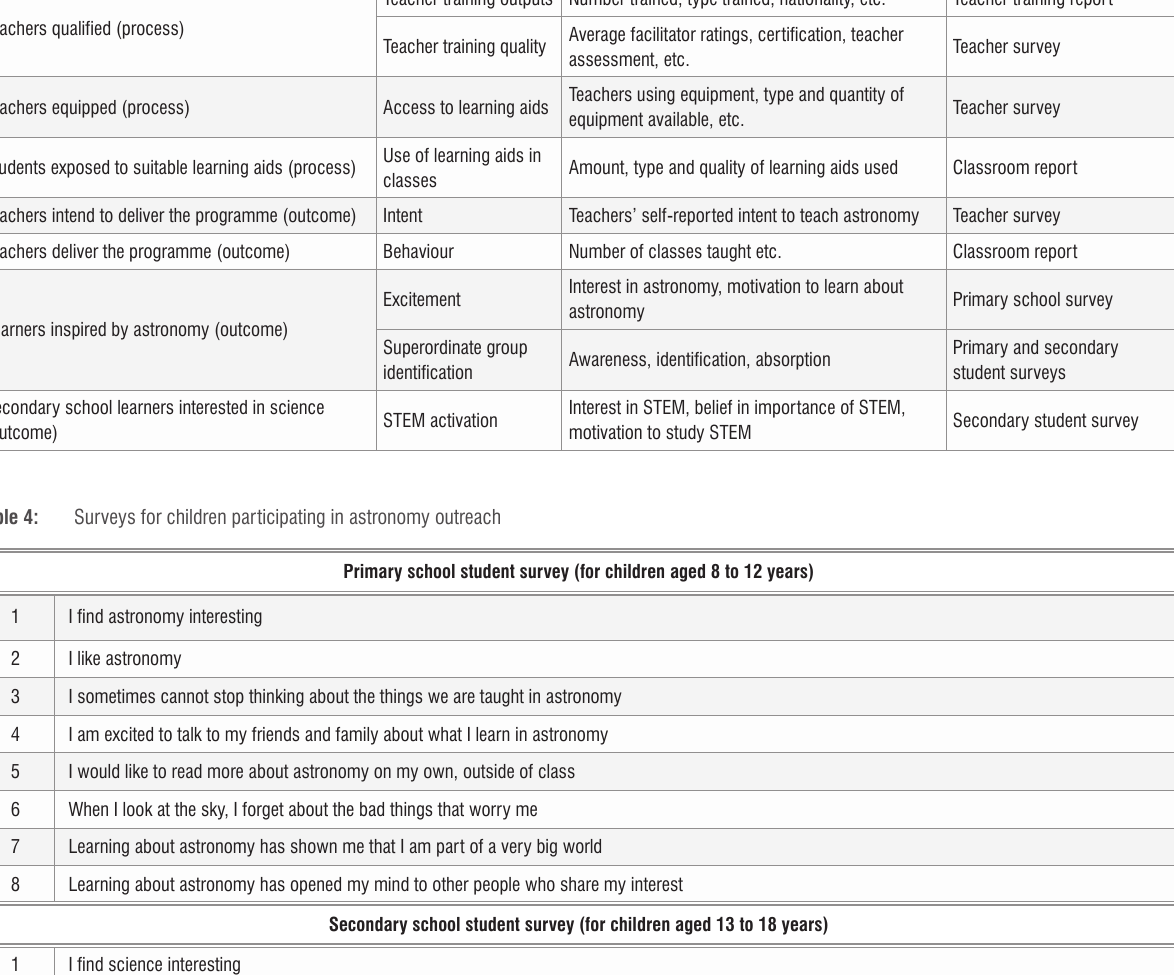
Process and outcome indicators and measures for the Programme for Children and Schools Process/Outcome Indicators